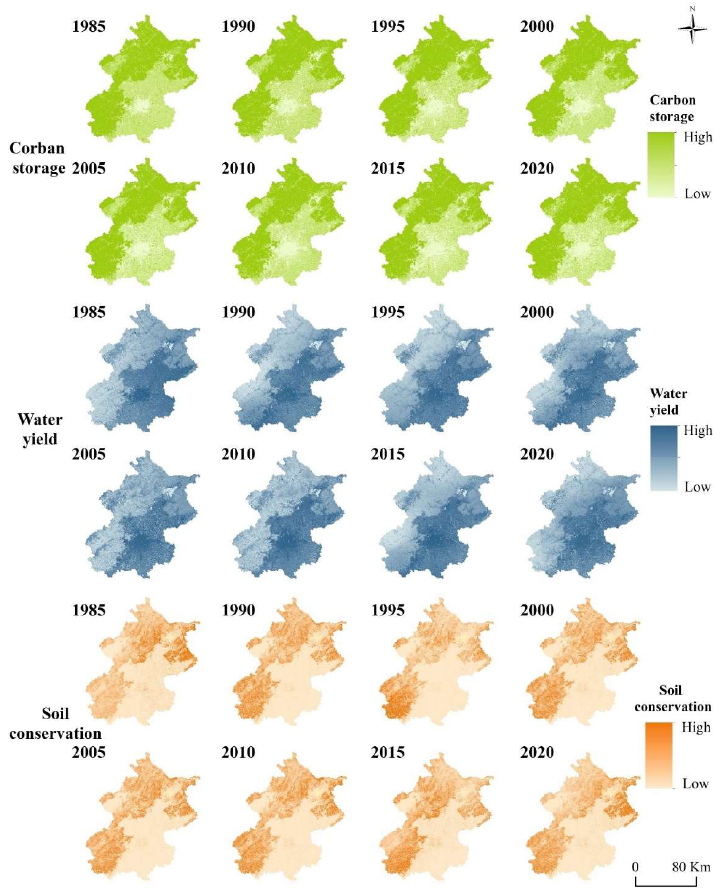
Figure 4. Spatial distribution of ESs from 1985 to 2020 in Beijing.